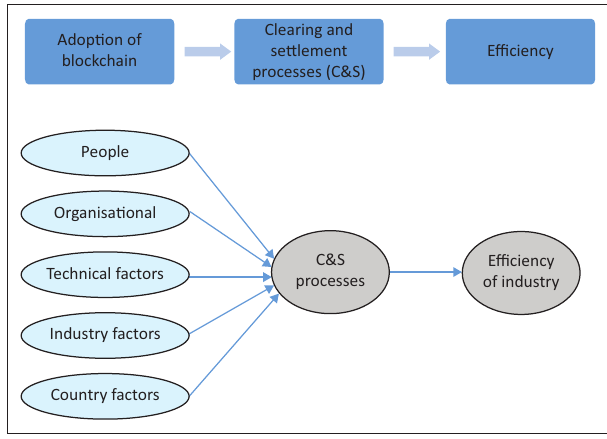
FIGURE 2: People, organisation, technology, industry and country framework: factors affecting the adoption of blockchain in the clearing and setllement